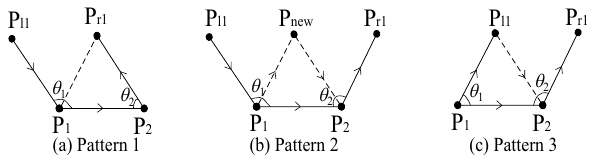
Figure 3. Three basic patterns of the input–output relationship.